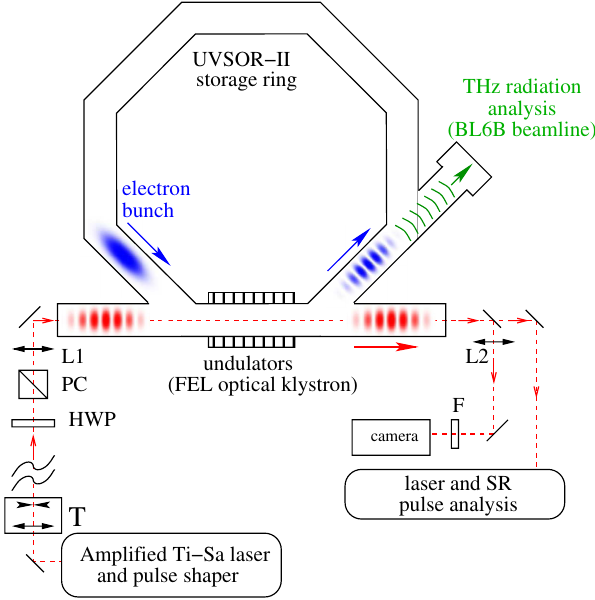
FIG. 3. Laser and pulse-shaper setup. The amplified laser system (from Coherent Inc.) is composed of a Mira oscillator, a Legend regenerative amplifier, and a Hidra multipass amplifier, whose uncompressed (chirped) output is used. The pulse shaper is composed of a Michelson interferometer and an adjustable compressor. The CCR2 Michelson retroreflector is mounted on a motorized translation stage, allowing to adjust the output pulse period T m . The pulse duration T D can be changed by adjusting the distance between gratings. The parts displayed in green (mirror and G2 grating) are fixed on the carrier of a single translation stage with wide range (60 cm). With this configura- tion, the output pulse delay is not significantly affected by the large displacements of the translation stage. CCR1 and CCR2 are protected gold-coated corner cube retroreflectors with low angular error (0.5 arc sec). RRF: roof retroreflector; M: mirrors (HR at 800 nm); BS: 50% beam splitter; G1 and G2: 1800 l = mm compression gratings from Spectrogon. Transport mirrors are not represented in detail. The compressor produces pulses whose duration is adjustable from (cid:1) 130 fs to 190 ps